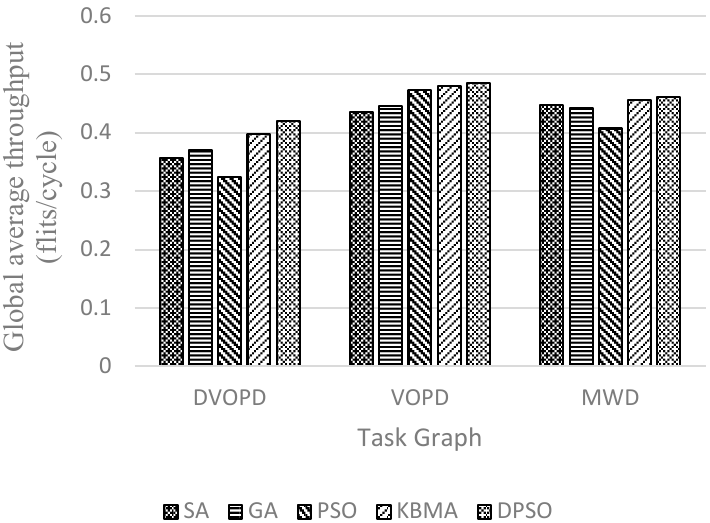
Figure 5. Throughput rate at DVOPD, VOPD and MWD on 4 × 4 × 4 3D mesh structure.